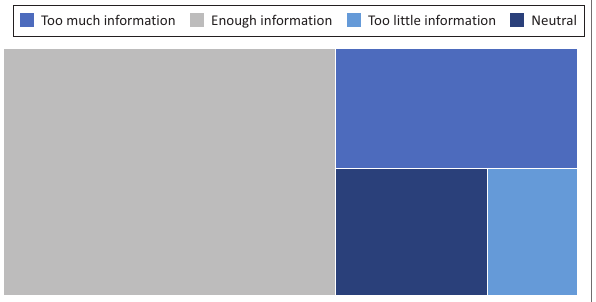
Enough informationToo much